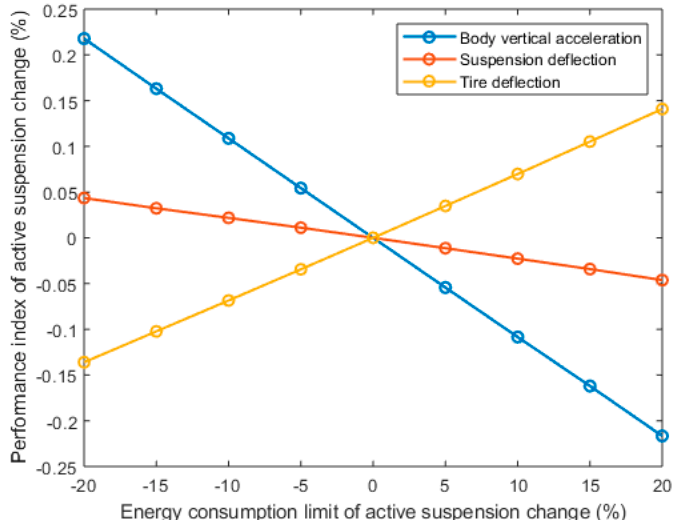
Figure 9. The sensitivity of the active suspension performance index to the 1.5 °C target active suspension energy consumption limit.